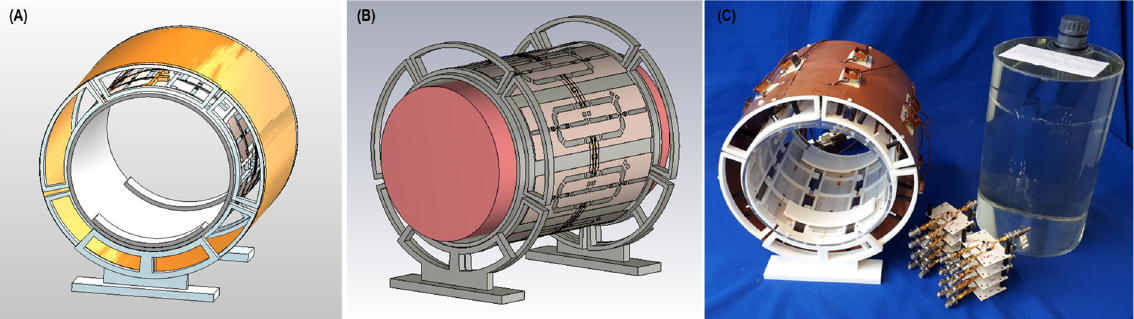
Figure 4. Experimental setup of the 8-channel loop–dipole RF transceiver array. ( A , B ) Computer- aided design of the RF transceiver array and the loop–dipole configuration decoupled with trans- formers. ( C ) Manufactured 8-channel loop–dipole RF transceiver array together with the phantom, the implant, the phantom container, and the power splitters used for RF feeding of the array.